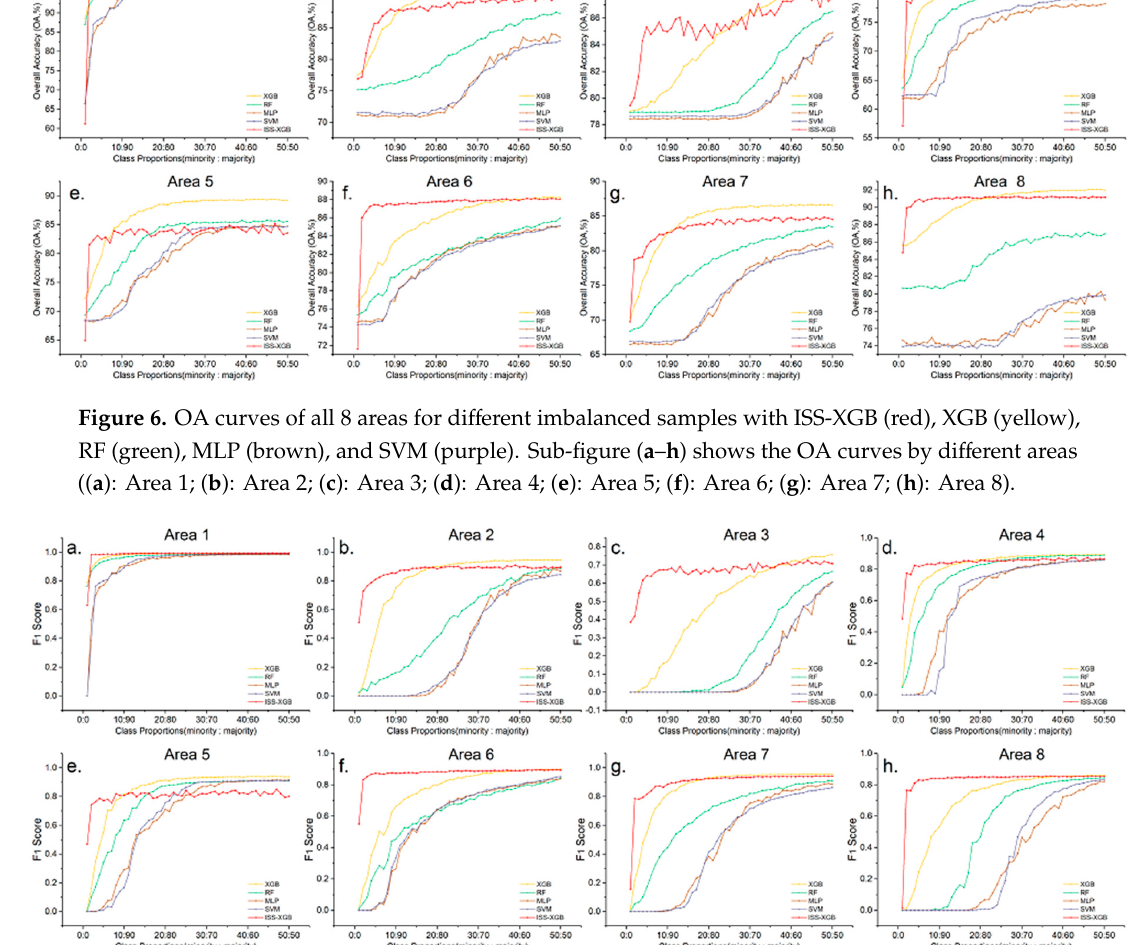
Figure 7. F 1 score curves for the minority classes for all 8 areas across different imbalanced samples with ISS-XGB (red), XGB (yellow), RF (green), MLP (brown), and SVM (purple). Sub-figure ( a – h ) shows the F 1 score curves by different areas (( a ): Area 1; ( b ): Area 2; ( c ): Area 3; ( d ): Area 4; ( e ): Area 5; ( f ): Area 6; ( g ): Area 7; ( h ): Area 8).